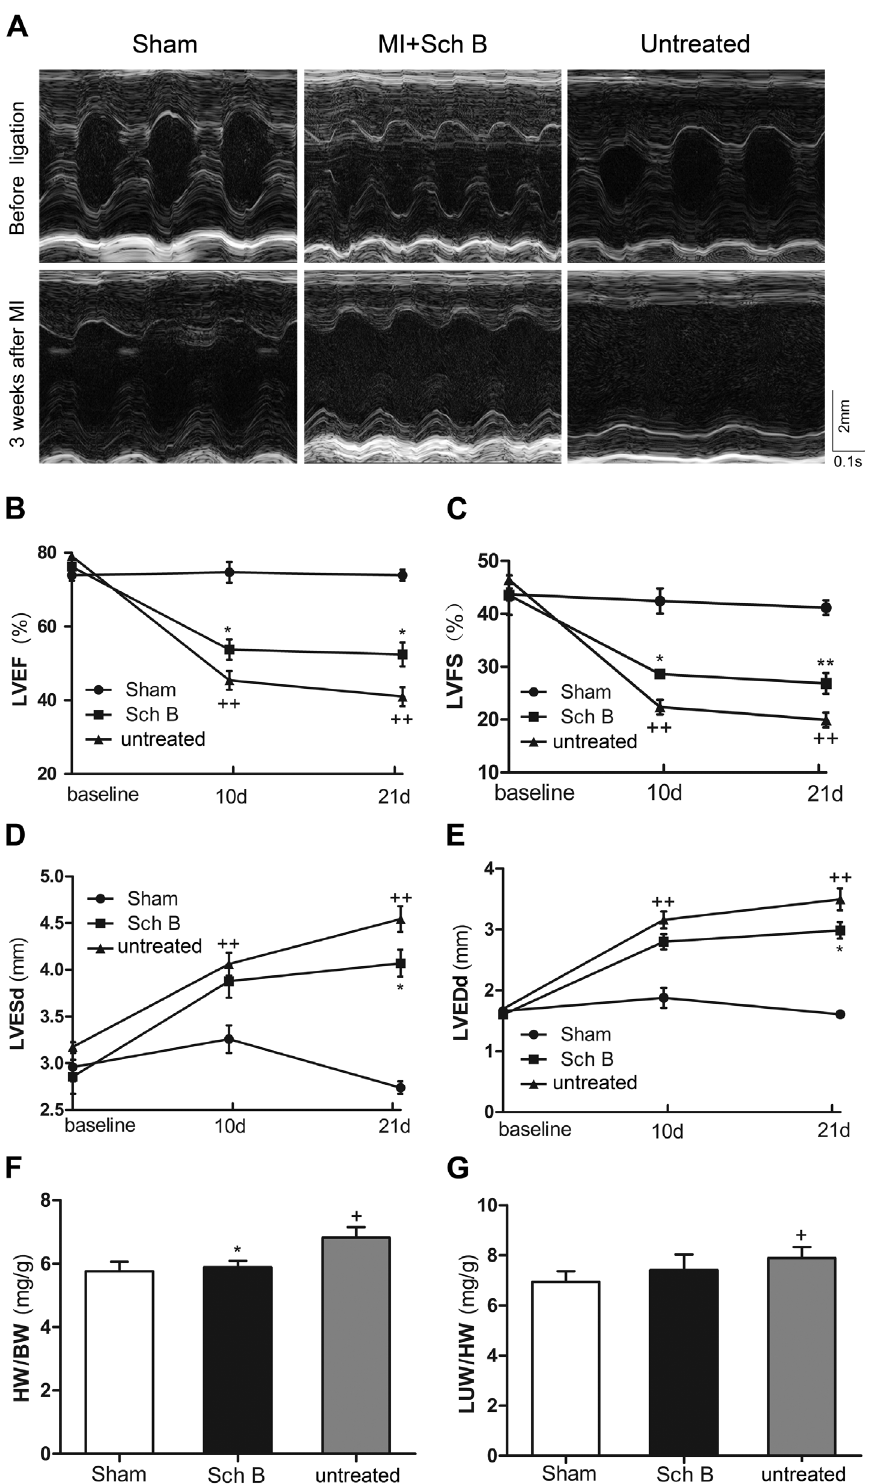
Figure 2. Sch B in the effects of cardiac remodeling in MI mice. (A) Representative M-mode echocardiographic images of mice. (B) Analysis of left ventricular ejection fraction (LVEF) at 10 d and 21 d after MI. (C) Analysis of left ventricular fractional shortening (LVFS) at 10 d and 21 d after MI. (D) Analysis of left ventricular end-systolic diameter (LVESd) at 10 d and 21 d after MI. (E) Analysis of left ventricular end-diastolic diameter (LVEDd ) at 10 d and 21 d after MI. (F) Analysis of heart weight/body weight ratio (HW/BW) at 10 d and 21 d after MI. (G) Analysis of the lung weight/body weight ratio (LUW/BW) at 10 d and 21 d after MI. n=8 in the sham-operated group, n=10 in the Sch B treated and untreated groups. * P , 0.05 versus untreated group, ** P , 0.01 versus untreated group, + P , 0.05 versus sham-operated group, ++ P , 0.01 versus sham-operated group.